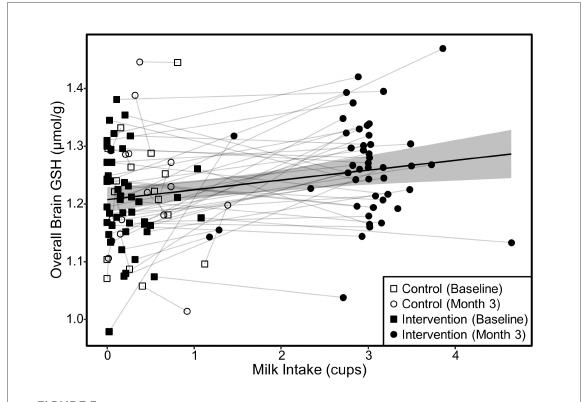
FIGURE5 Relationship between milk intake and overall brain GSH concentration in both groups. The scatterplot demonstrates the relationship ( β = 0.02, p < 0.001) between milk intake and GSH concentrations determined by a linear mixed model of overall brain GSH concentration as a function of milk intake including the random effect of subject ID to account for repeated measures and individual variance in GSH concentrations. Relationships were similar for the parietal and fronto-parietal regions ( β = 0.02 and p < 0.001 for all). The shaded area represents the 95% confidence interval for the fixed effect of milk intake.